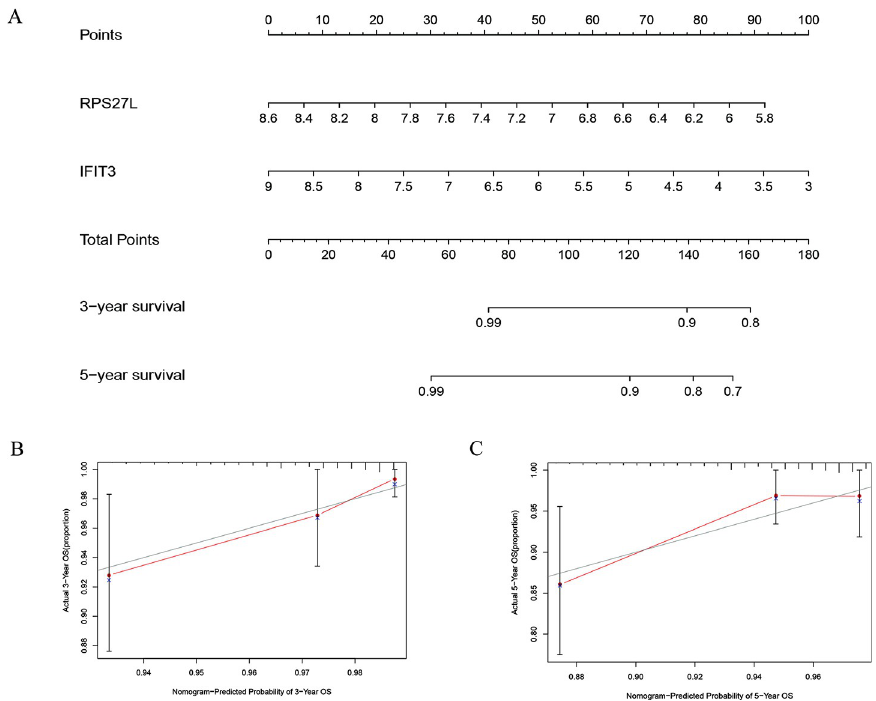
Fig 5. Nomogram and calibration plots of RBPs. (A) Nomogram to predict 3- and 5-year OS in the TCGA cohort; (B, C) Calibration plots of the nomogram to predict OS at 3 and 5 years.